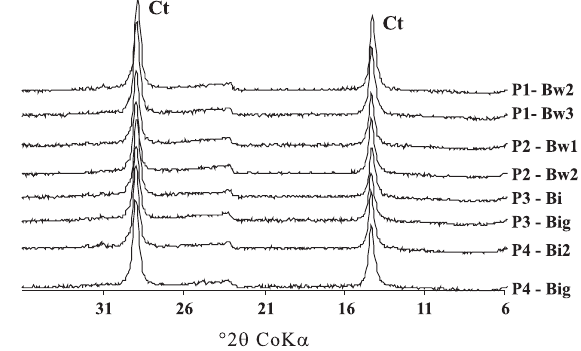
Figura 2 Difratogramas de raios X de amostras da fração argila desferrificada de horizontes subsuperficiais de perfis de solo das parcelas experimentais da PIF coco, Frutese, Platô